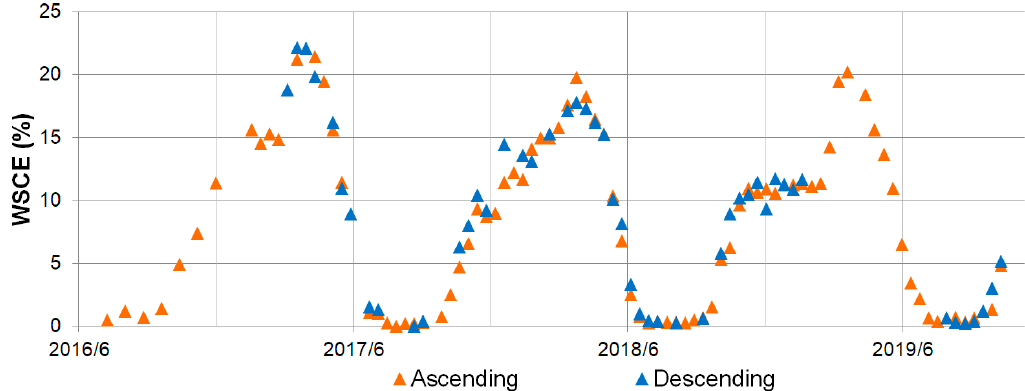
Figure 11. The estimation of the wet snow-covered extent (WSCE) percentage of the Brahmaputra River watershed using ascending and descending Sentinel-1 SAR imagery.